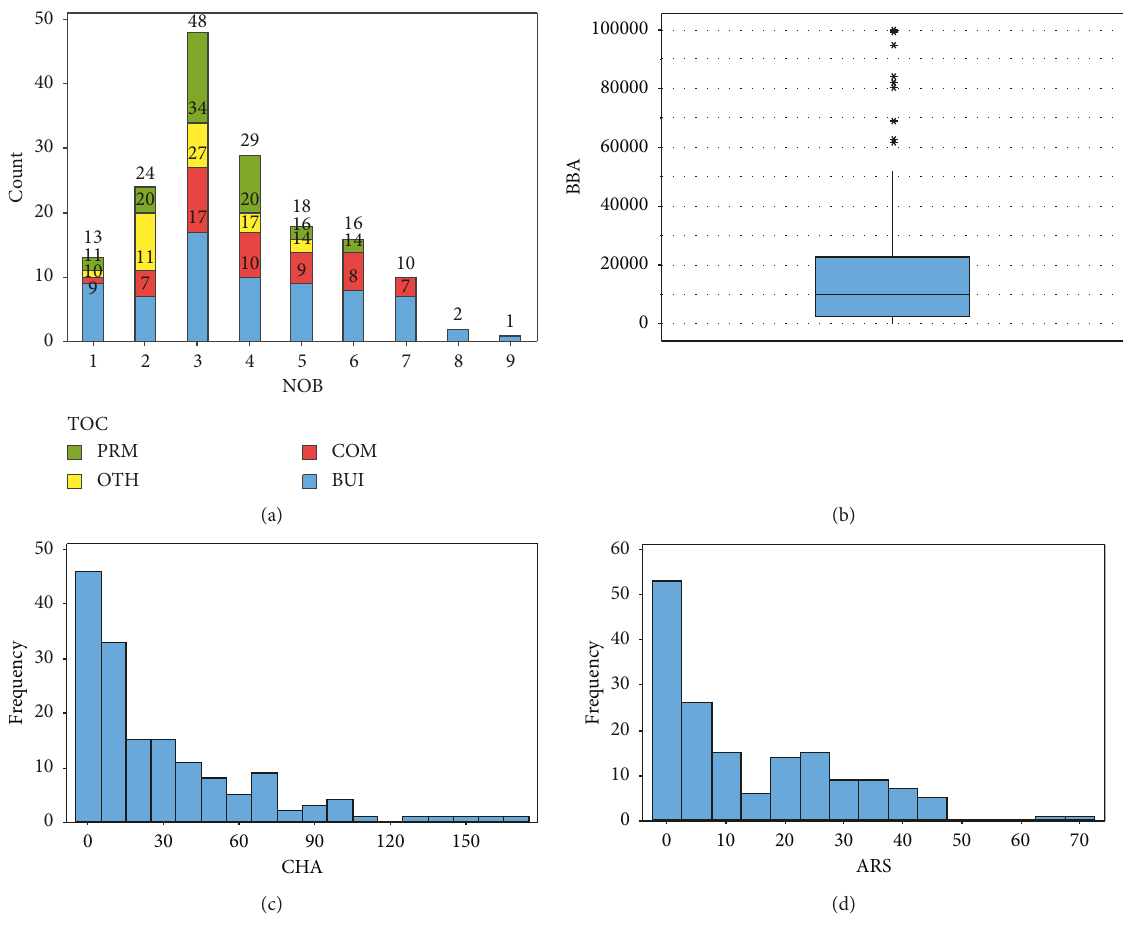
Figure 1: Distributions of the data for the following variables: (a) bar chart of NOB stacked by categories in TOC, (b) boxplot of BBA 1 , (c) histogram of CHA 2 , and (d) histogram of ARS. 1 Records with BBA > 100,000 ( n � 8) were not depicted. 2 Records with CHA > 200 ( n � 4) were not depicted. Table 4: Contingency table for the χ 2 test among the type of contract and the dichotomized number of bidders for the con- struction e-RA